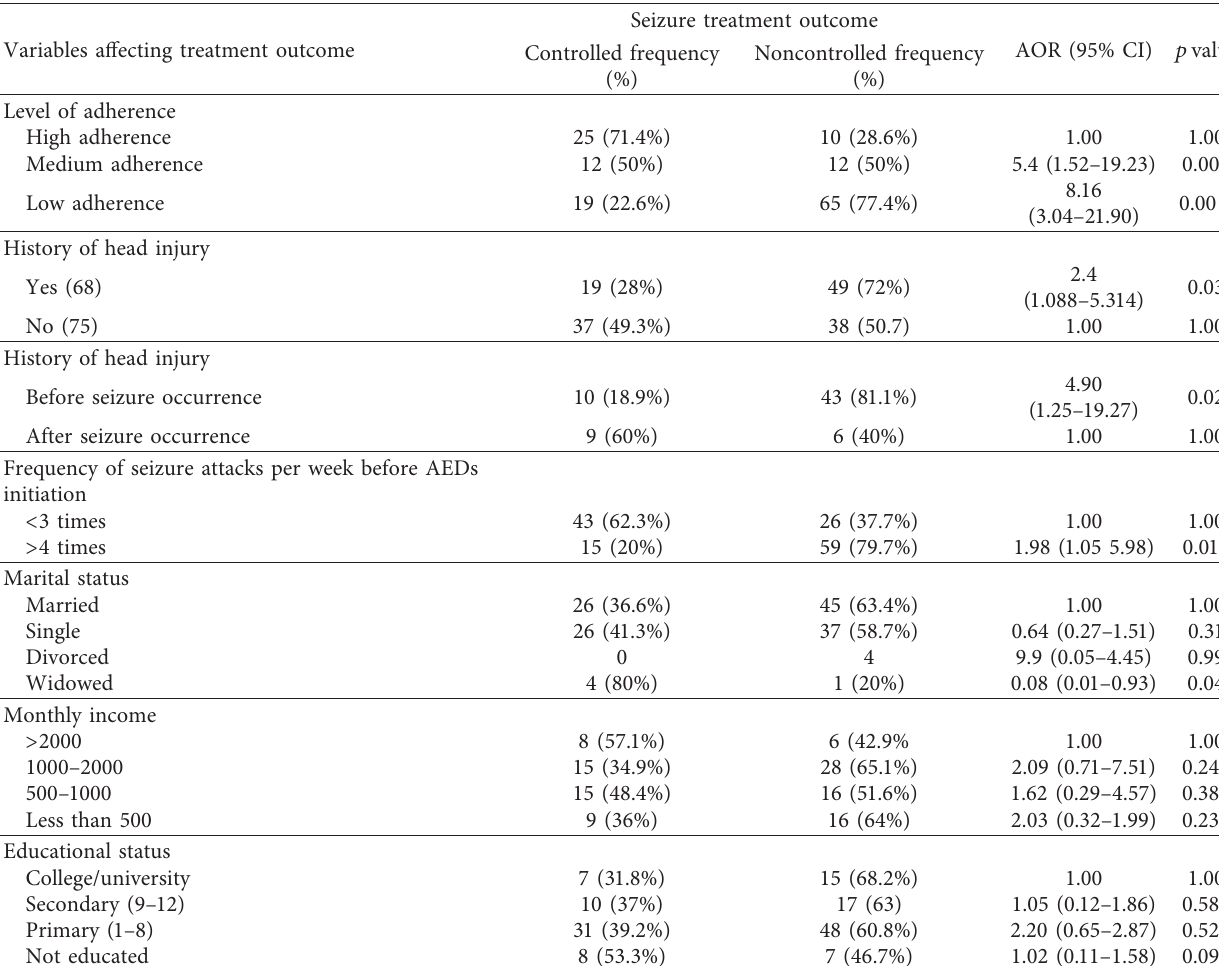
Table 5: Predictors of poorly controlled seizure among epileptic patients on AEDs at MTUTH from March 10 to April 10, 2018. Variables affecting treatment